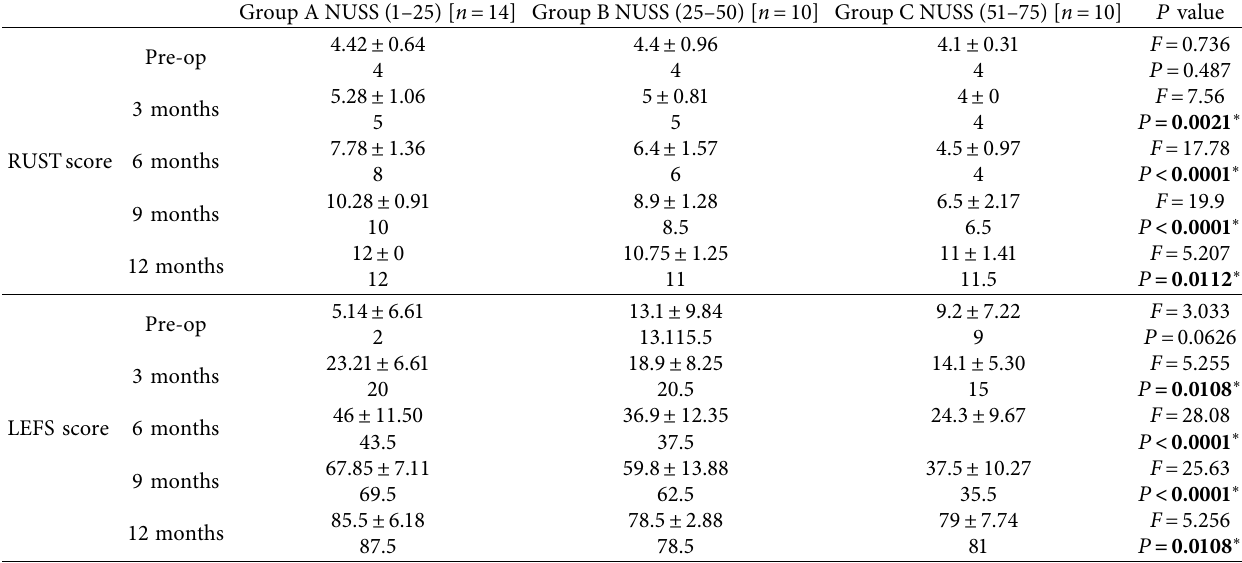
Table 4: Intergroup analysis of mean RUST and LEFS